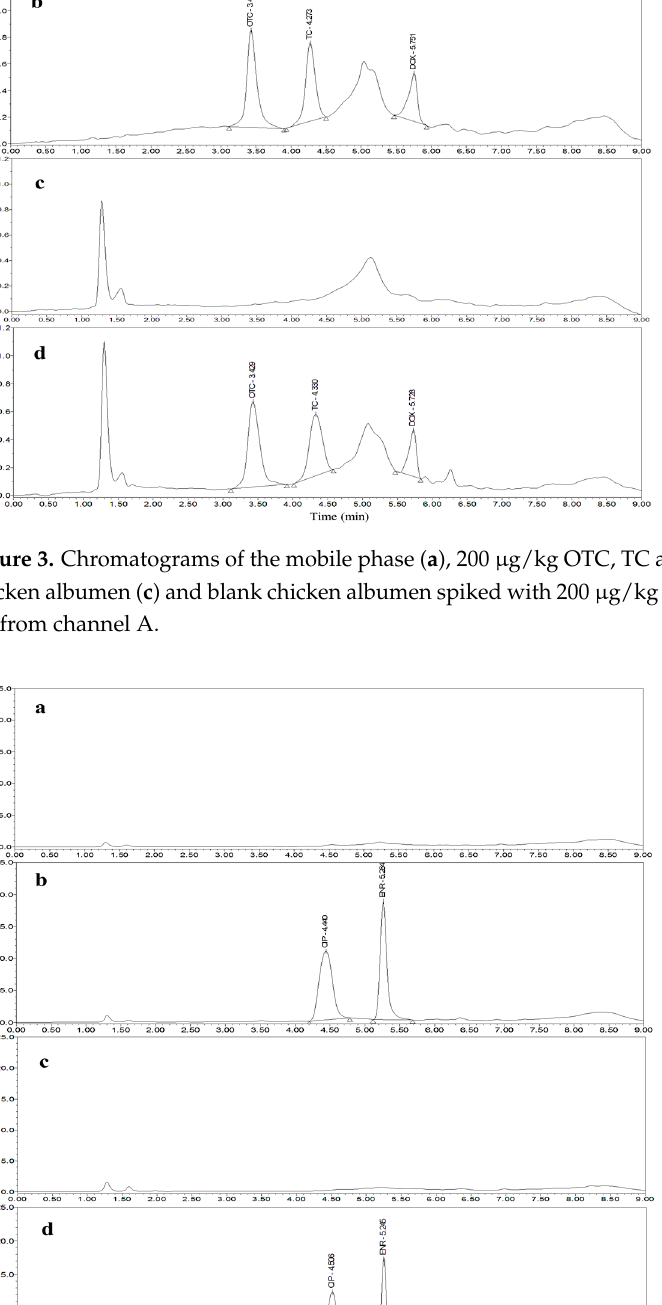
Figure 4. Chromatograms of the mobile phase ( a ), 50 μ g/kg CIP and 25 μ g/kg ENR standards ( b ), blank chicken albumen ( c ) and blank chicken albumen spiked with 50 μ g/kg CIP and 25 μ g/kg ENR standards ( d ) from channel B.